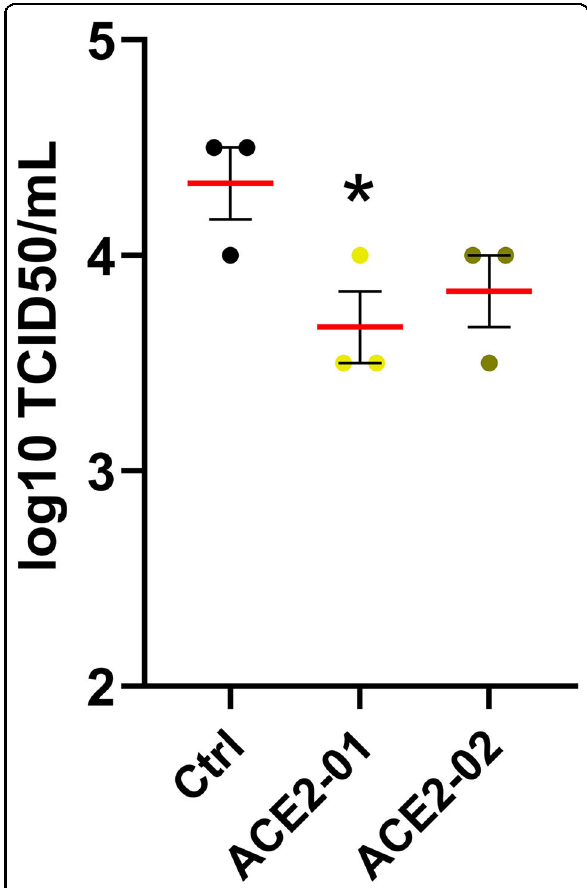
Fig. 2 o TCID50 assay to measure infectious viral titers in the culture. Data represent mean ± SEM, n = 3. Unpaired t -test, *P < 0.05 denotes signi fi cant